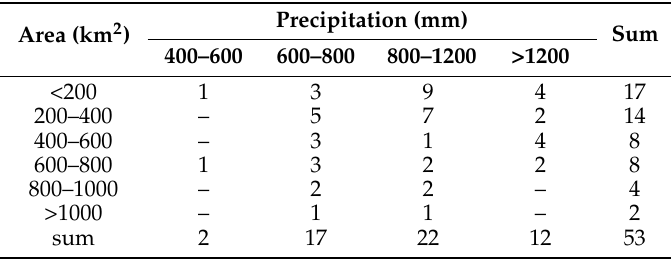
Figure 3 Spatial distribution of 53 watersheds in the southwestern area of Australia. Figure 3. Spatial distribution of 53 watersheds in the southwestern area of Australia. Table 3. Watersheds distribution on watershed area and annual precipitation. Table 3. Watersheds distribution on watershed area and annual